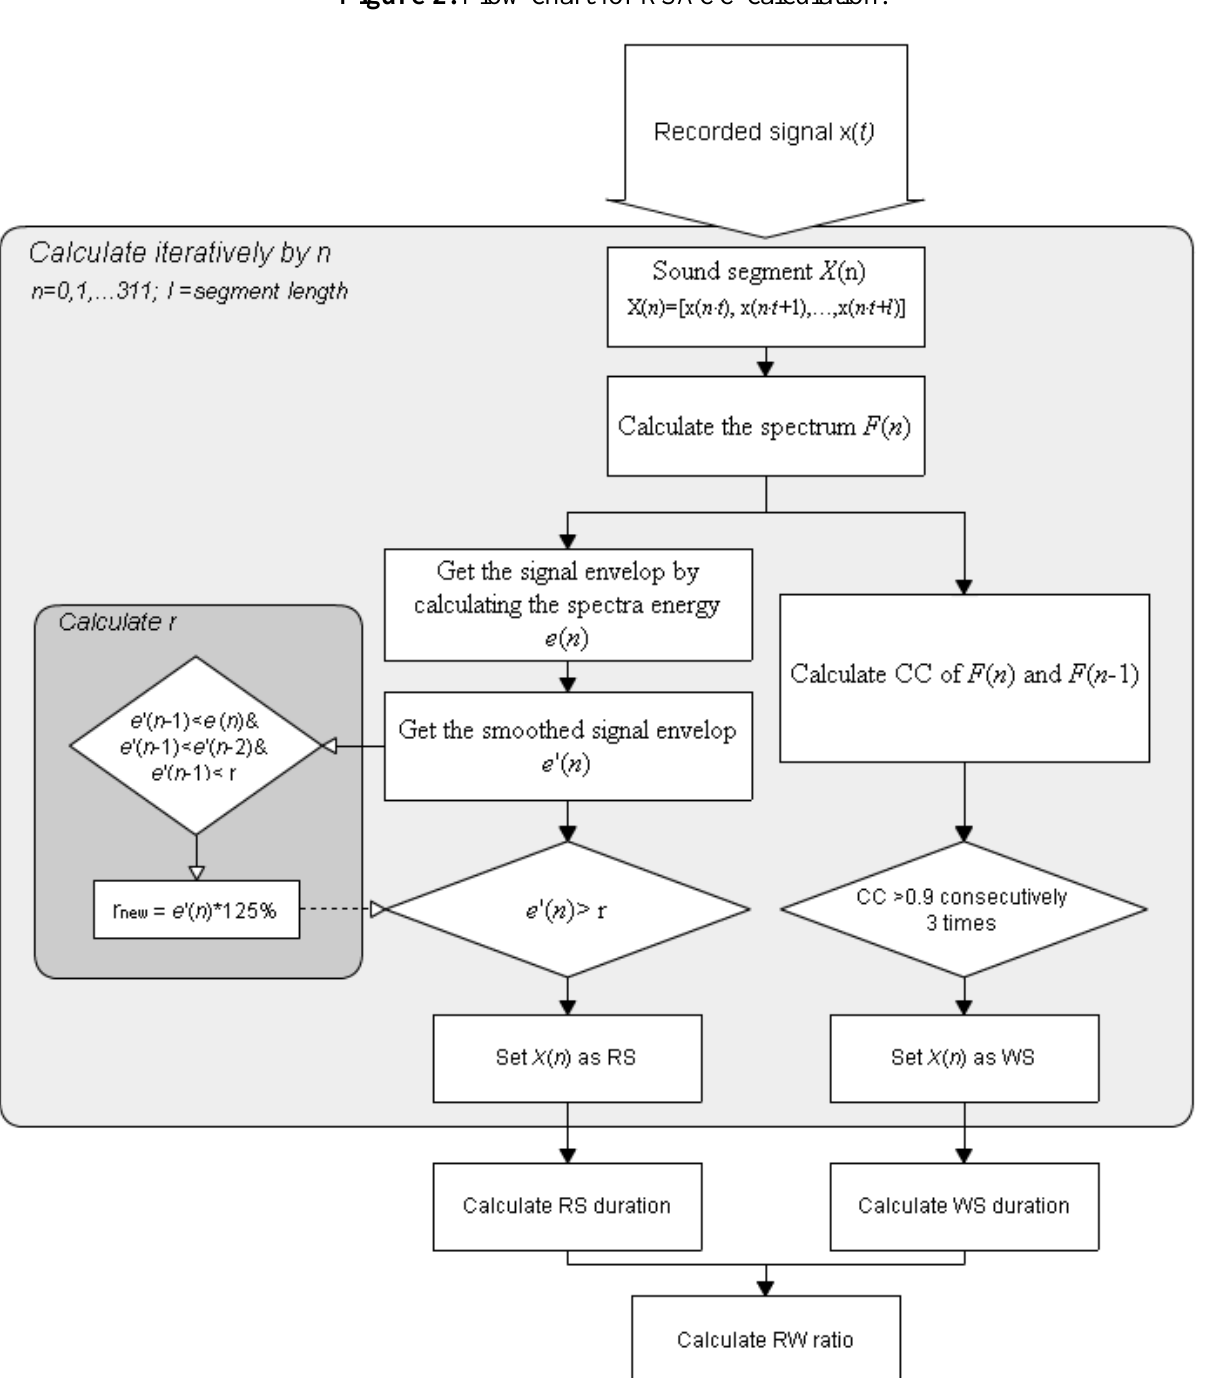
Figure 2. Flow chart for RSACC